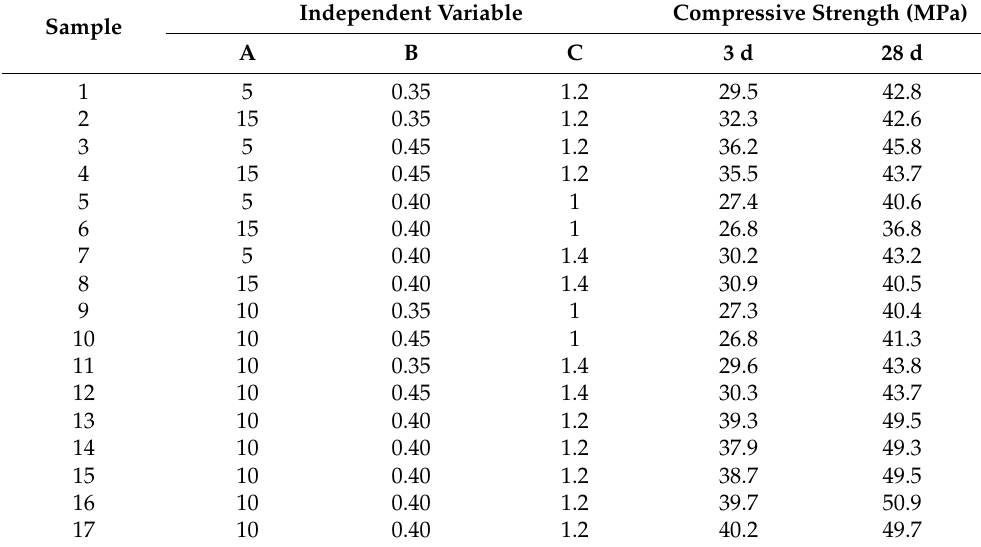
Table 3. Design and results of the Box–Behnken test.